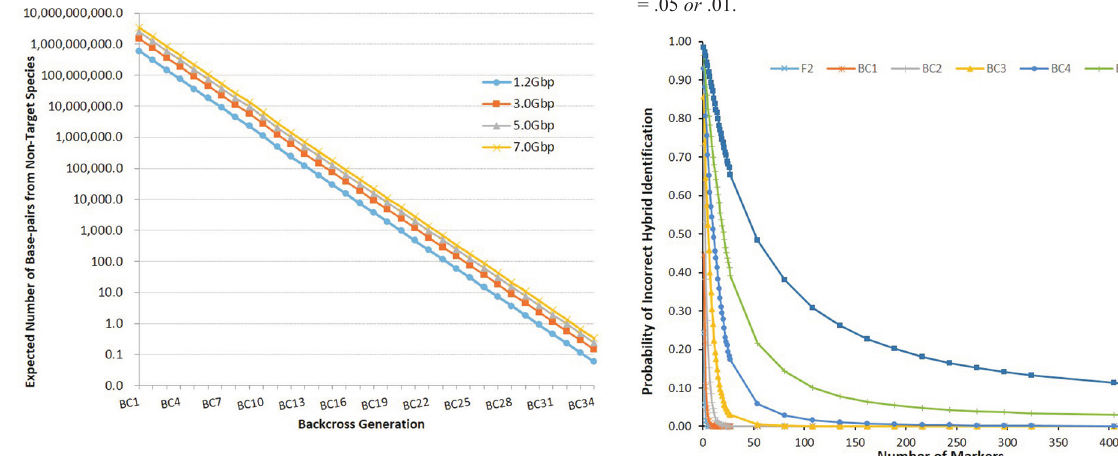
Figure 3 - Expected number of base-pairs from a non-target species con- sidering number of backcross generation with a target species with ge- nome size varying from 1.2 to 7.0Gbp. Table 2 - – Estimated numbers of bi-allelic markers required to identify hybrid individuals in different intercross and backcross populations be- tween a target and a non-target species based on power analysis, consider - ing p = 7.62939E-10 and Power (1 - (cid:4) ) (cid:15) 99%, and observed on simulated populations, respectively.